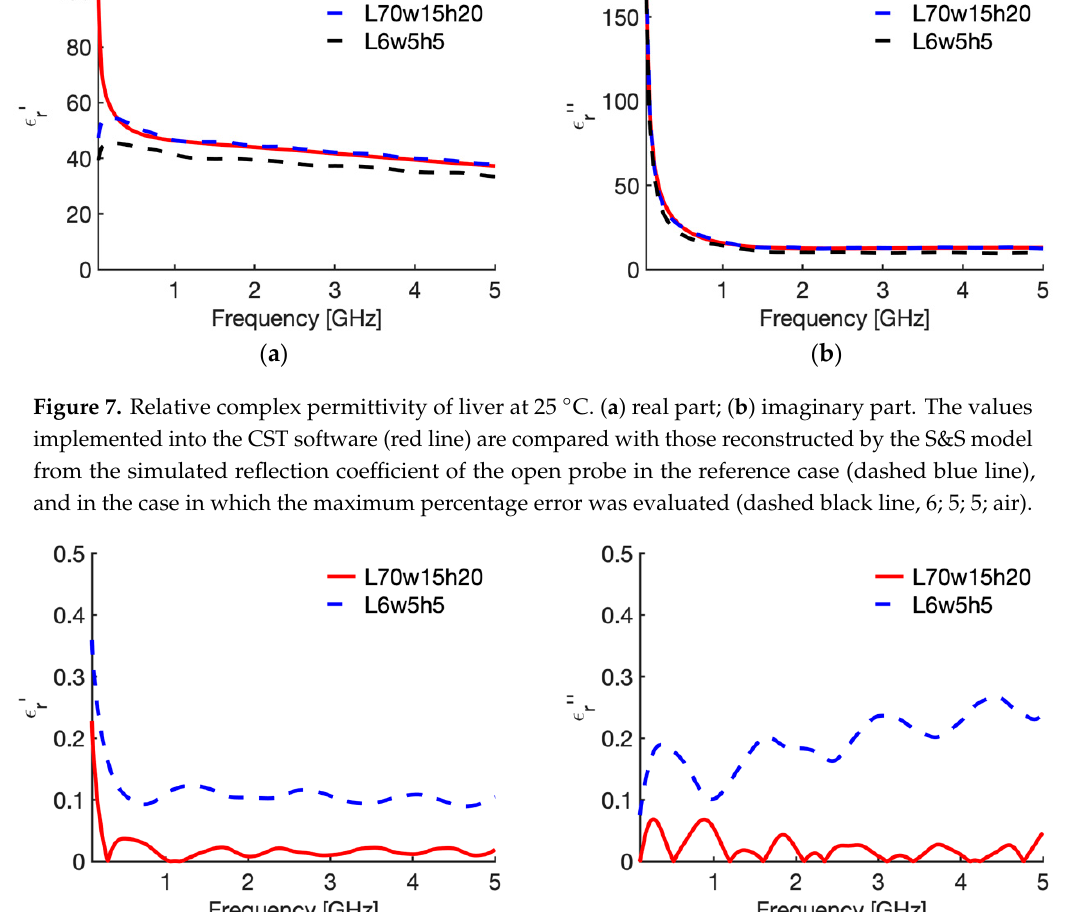
Figure 8. Percentage errors in the evaluation of the relative complex permittivity of liver at 25 °C